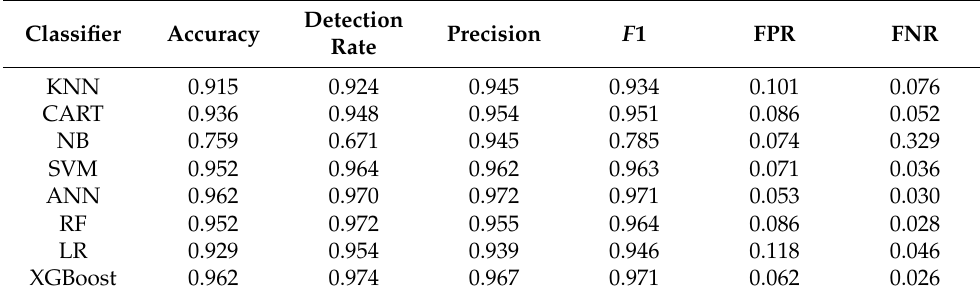
Table 2. Accuracy ( ACC ), Detection Ratel ( DR ), Precision ( P ), F -measure ( F 1), False positive rate (FPR), and False negative rate (FNR) for the proposed models with k = 0.5.